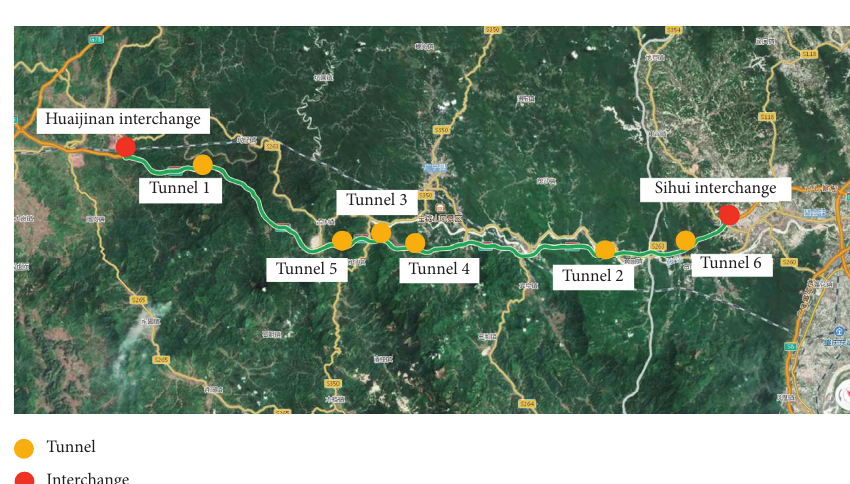
Figure 1: Selected test tunnels along the No. G55 expressway, Guangdong, China.